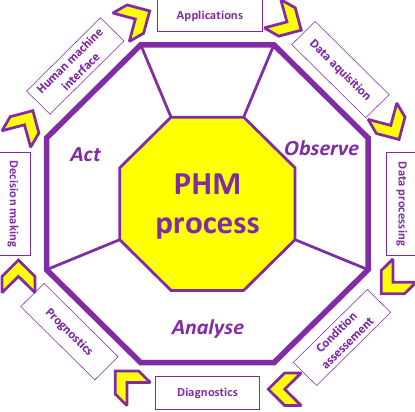
Figure 3. Prognostics health management (PHM) process.